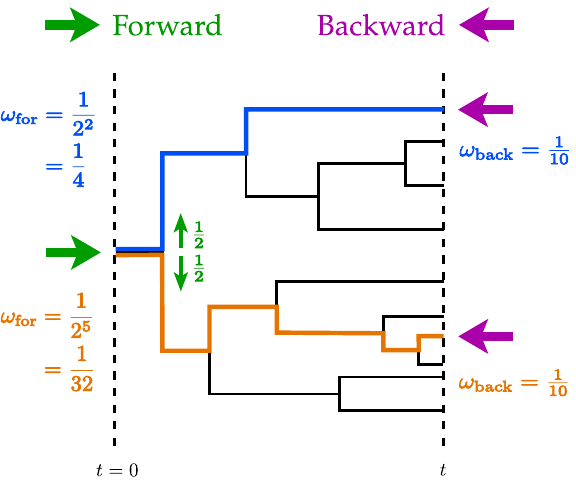
Figure 1. Example of a tree with N 0 = 1 and N ( t ) = 10 lineages at time t . Two lineages are highlighted, the first in blue with 2 divisions and the second in orange with 5 divisions. The forward sampling is represented with the green right arrows: it starts at time t = 0 and goes forward in time by choosing one of the two daughters lineages at each division with probability 1/2. The backward sampling is pictured by the left purple arrows: starting from time t with uniform weight on the 10 lineages it goes backward in time down to time t = 0